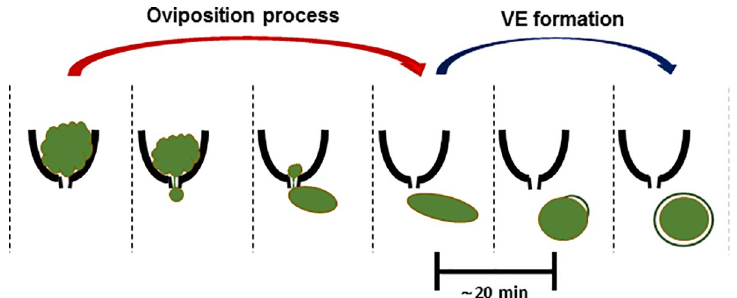
Fig 5. Schematic illustration of the oviposition process and vitelline envelope formation in Daphnia magna . An ovarian egg is extruded into the egg canal, and the egg contents accumulate outside the ovary. The egg undergoing extrusion continues to elongate until oviposition is completed. Thereafter, the VE forms within 20 min.